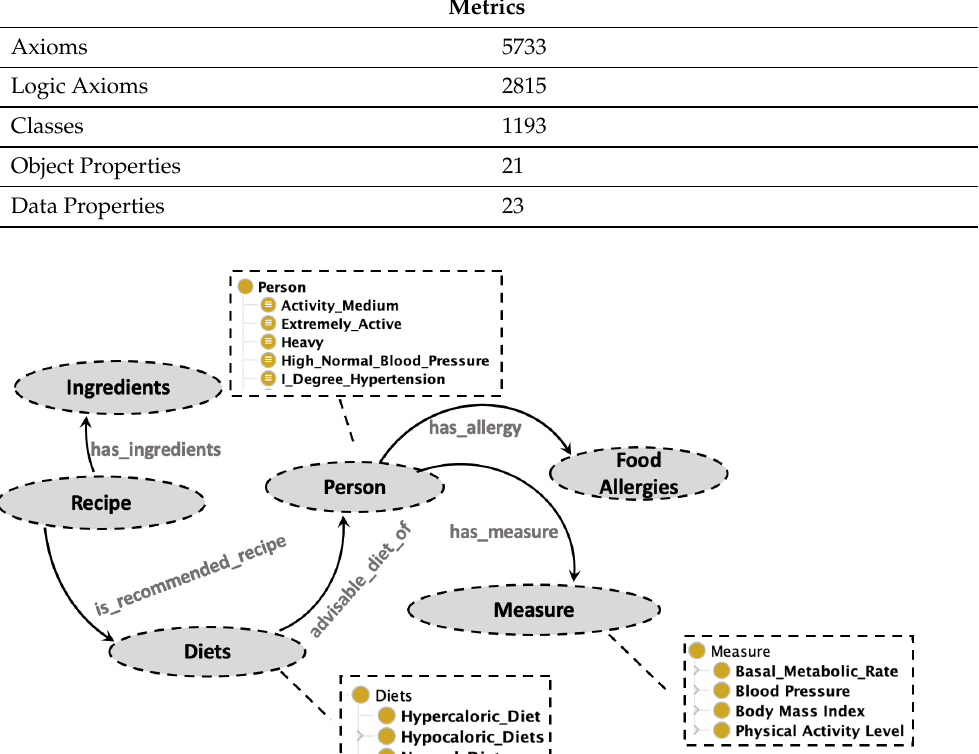
Table 2. The ODR’s main metrics.